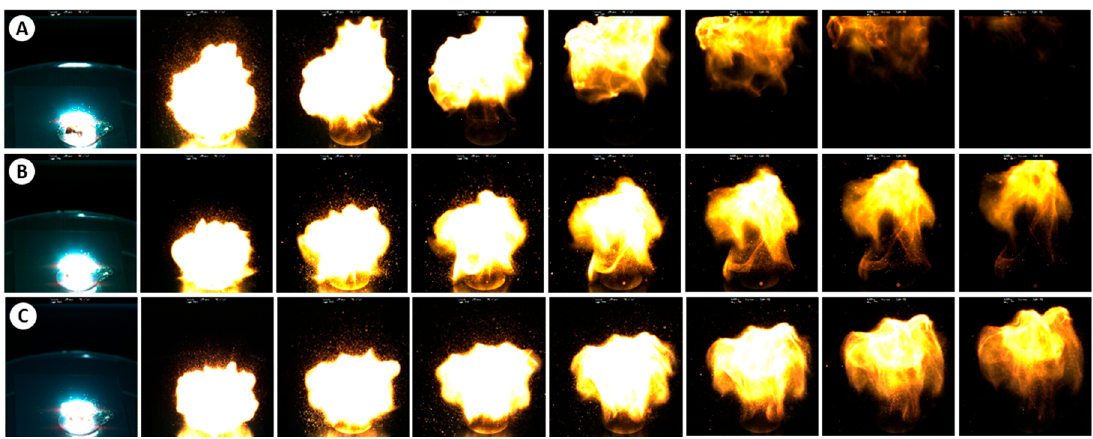
Figure 6. Sequences of the combustion images of the ( A ) Al/WO 3 , ( B ) Al/WO 3 /C suc and ( C ) Al/WO 3 /C cell nanothermites. The first image of each series corresponds to the ignition of the energetic powders. The elapsed time between pictures is 200 µs.